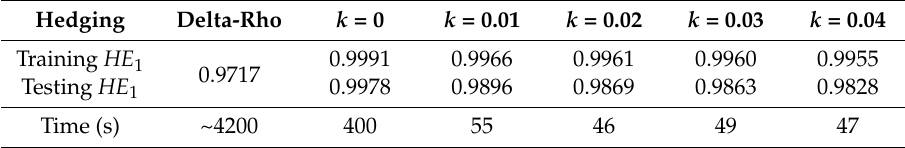
Table 6. Hedging metrics for different hedging strategies and error functions for guaranteed minimum withdrawal benefit